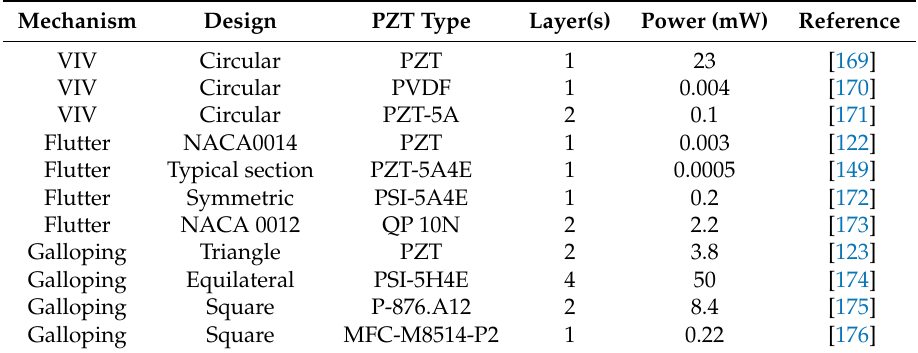
Table 2. Comparison of various FSI-based